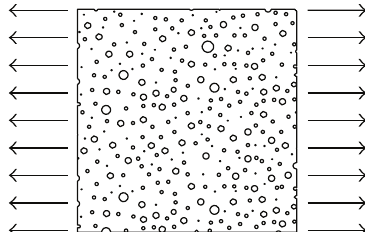
Figure 5: An elastic plate with many pores subjected to uniaxial